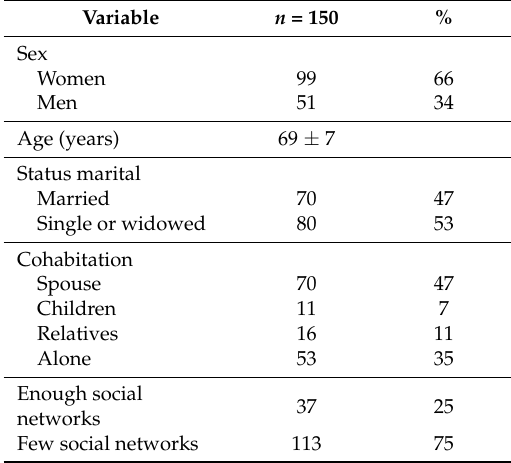
Table 1. Socio-demographic characteristics and social support